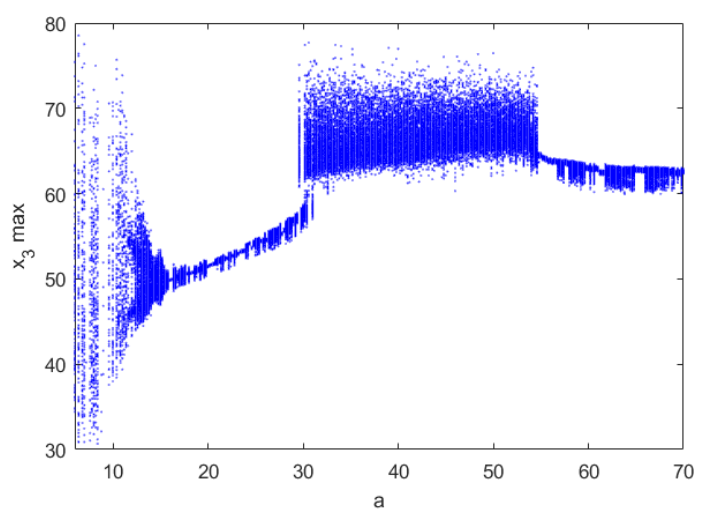
Figure 7. Bifurcation diagram for a ∈ [ 6,70 ] .